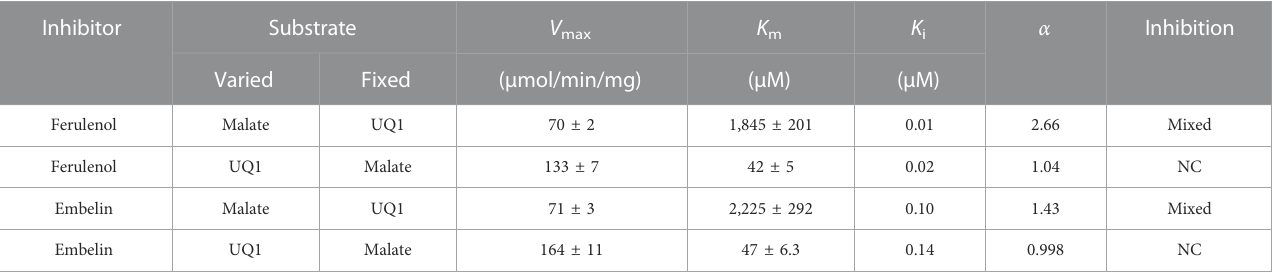
TABLE 3 Kinetic parameters of the inhibition by ferulenol and